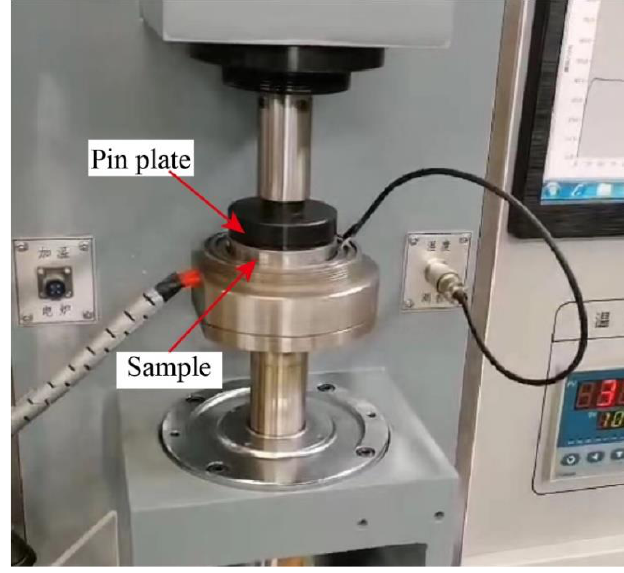
Figure 3. MMW-1A friction and wear testing machine. Table 4. Parameters of the friction-wear test.